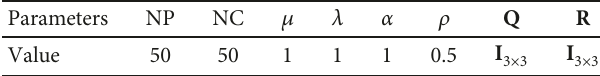
Table 3: DE-run parameters and weights of the cost function.